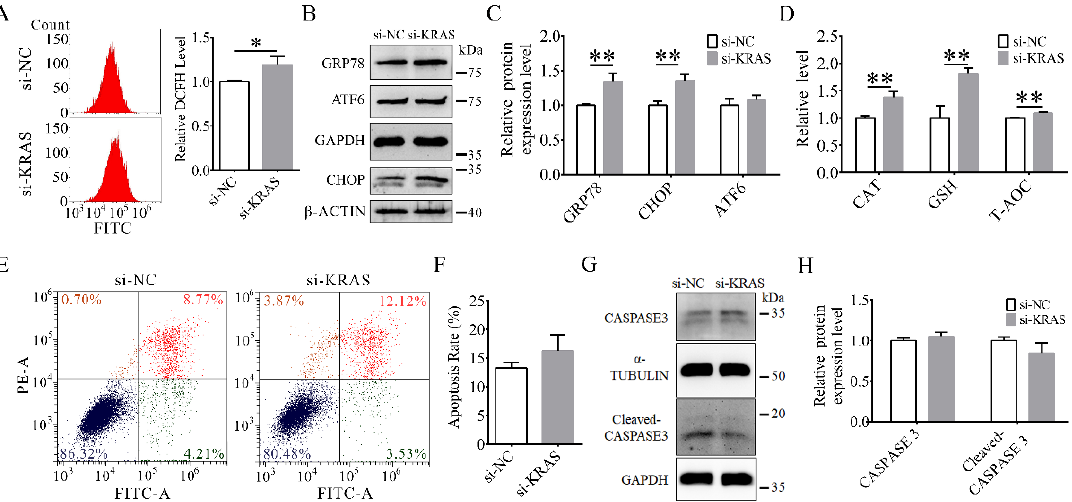
Figure 5. Effects of Kirsten rat sarcoma viral oncogene homolog (KRAS) on reactive oxygen species (ROS) and endoplasmic reticulum (ER) stress in MAC-T cells. ( A ) Representative flow cytometry images of ROS content and relative dichlorofluorescein (DCFH) levels in MAC-T cells with or without KRAS inhibition. ( B , C ) Representative Western blot images and relative protein levels of glucose-regulated protein 78 (GRP78), activating transcription factor 6 (ATF6), and C/EBP homologous protein (CHOP) in MAC-T cells with or without KRAS inhibition. The β -ACTIN loading controls were performed for CHOP on the same membrane. ( D ) Relative levels of catalase (CAT), glutathione (GSH), and total antioxidant capacity (T-AOC) in MAC-T cells with or without KRAS inhibition. ( E , F ) Representative flow cytometry images and apoptosis rate in MAC-T cells with or without KRAS inhibition. ( G , H ) Representative Western blot images and relative protein expression levels of CASPASE 3 and cleaved-CASPASE 3 in MAC-T cells with or without KRAS inhibition. Significant differences are represented with * ( p < 0.05) and ** ( p < 0.01).